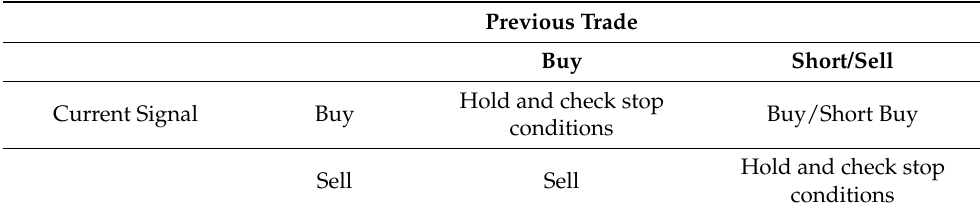
Table 5. Actions taken by the backtesting algorithm based on the previous trade and signal generated by the classifier for the current